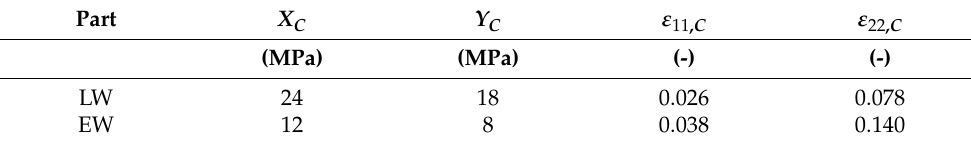
Table 4. Estimated material parameters for compressive loading for EW and